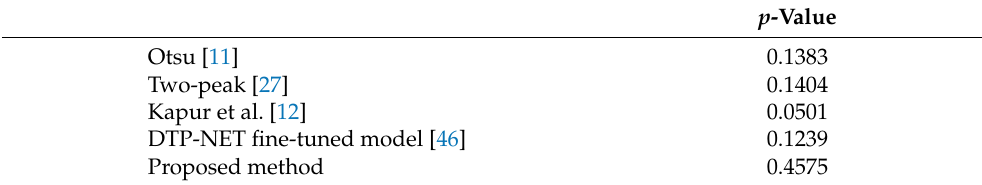
Table A1. p -values obtained for Shapiro–Wilk analysis using the PSNR values of Otsu [11], two- peak [27], Kapur et al. [12], DTP-NET (fine-tuned model) [46], and the proposed method.